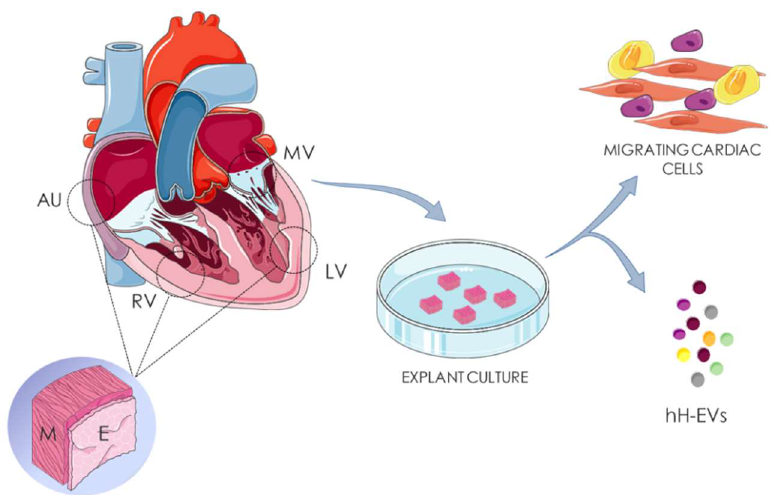
Figure 8. Isolation of heart-derived extracellular vesicles. Human cardiac fragments of right auricle (AU), right ventricle (RV), left ventricle (LV) and mitral valve (MV) were obtained from cadaveric donors. Endocardial (E) and myocardial (M) tissues of AU, RV, LV were separated before culture. The samples were dissociated in fragments of 3 mm² and culture for human heart-derived extracellular vesicles (hH-EVs) and cardiac cells isolation.